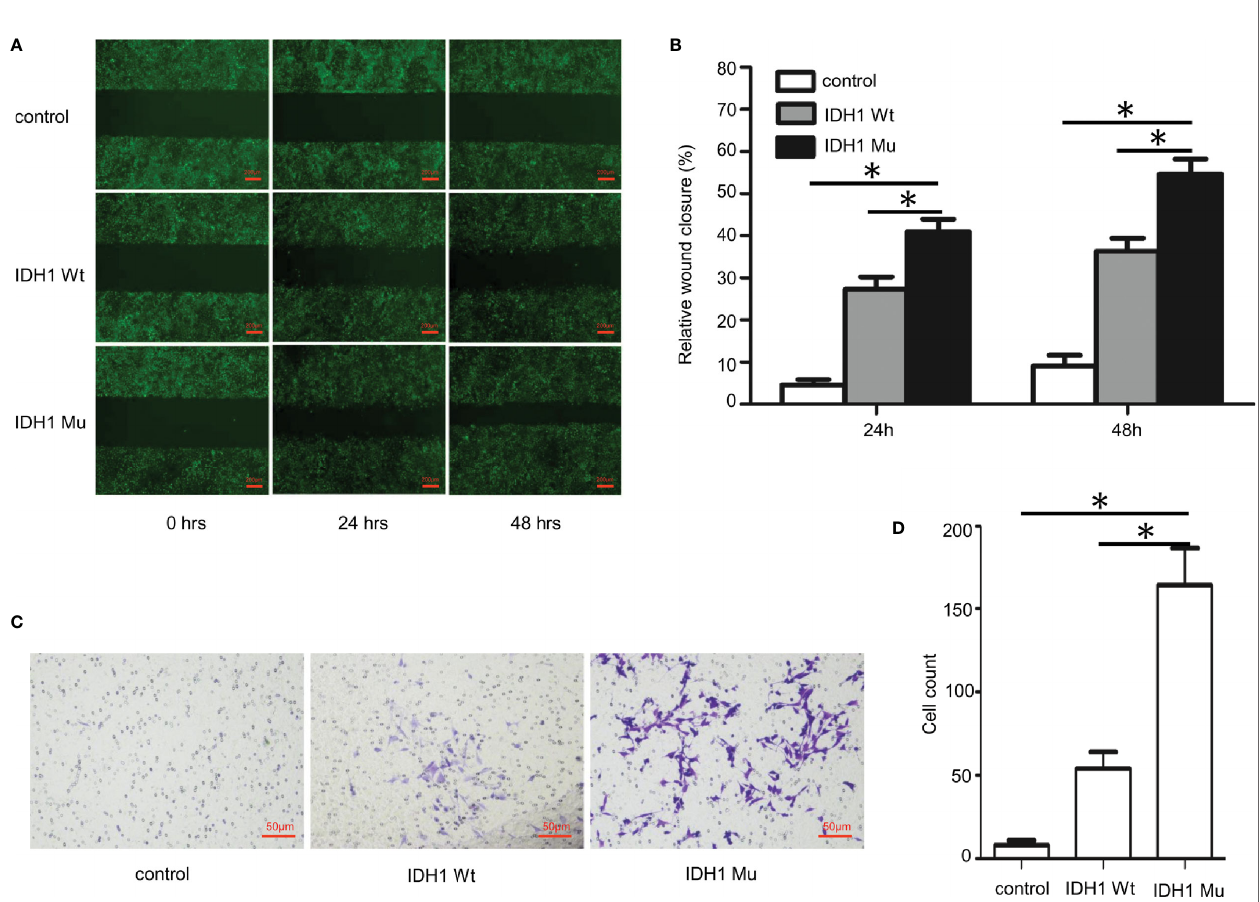
FIGURE 5 | Impact of the IDH1 R132C mutation on chondrocyte migration. The mouse chondrogenic ATDC5 cells were transduced with IDH1 wt and IDH1 mu (R132C) lentiviruses and then induced into chondrocytes as described. ATDC5 cells transduced with empty lentiviruses served as a control. (A) Representative images of each group from typical scratch migration assays. (B) A bar graphic fi gure shows the results of 5 independent scratch migration assays conducted. (C) Representative images of each group from transwell migration assays. (D) A bar graph shows data collected from 3 independent transwell migration assays.